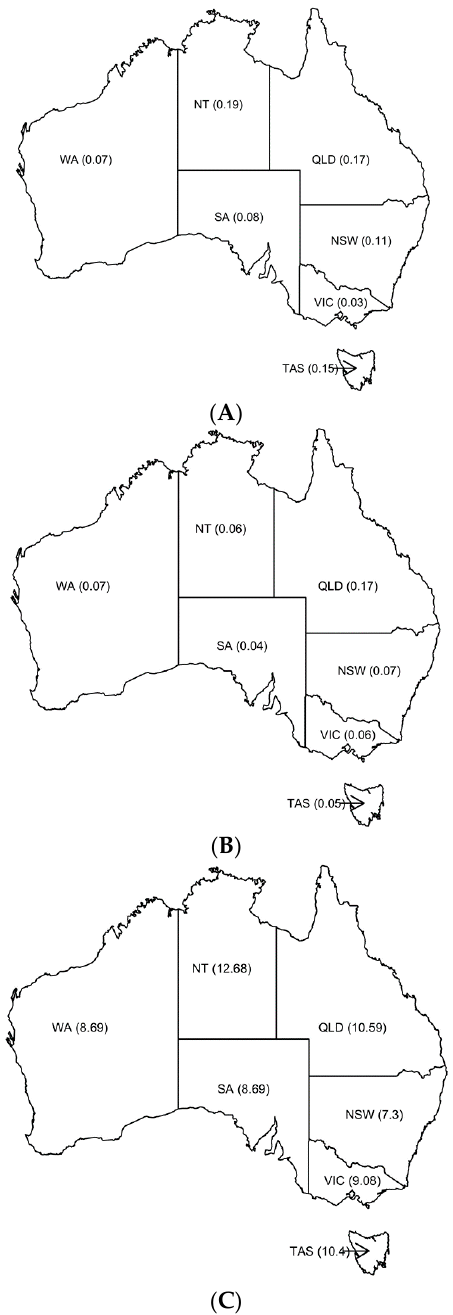
Figure 2. Numbers per capita (1000) of relinquished dogs on Gumtree ( A ) and PetRescue ( B ) from 8 to 24 February 2016, and total dog surrenders from Chua, Rand and Morton 2017 [2] ( C ) for each Australian State/Territory. Abbreviations used are: New South Wales (NSW), Victoria (Vic), Queensland (Qld), Western Australia (WA), South Australia (SA), Tasmania (Tas), Australian Capital Territory (ACT) and Northern Territory (NT)